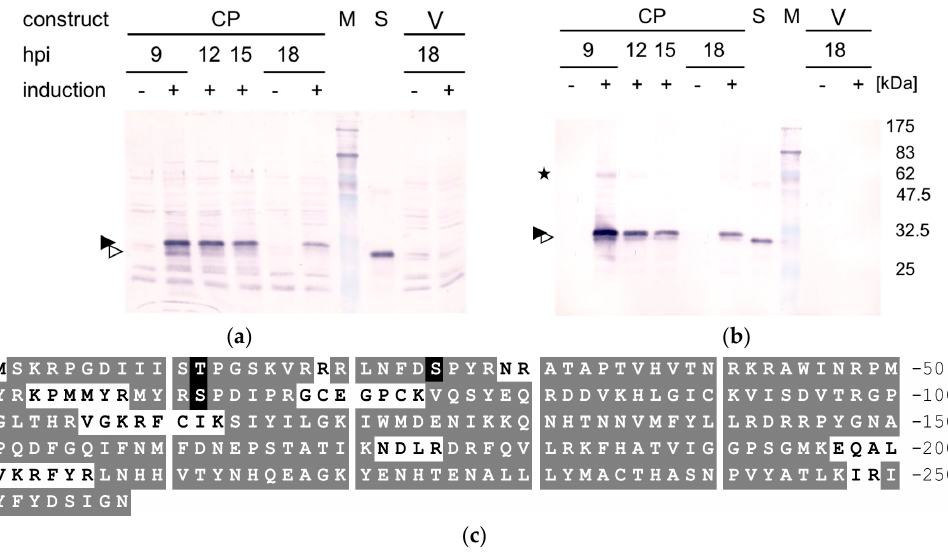
Figure 1. Cont. Figure 1.